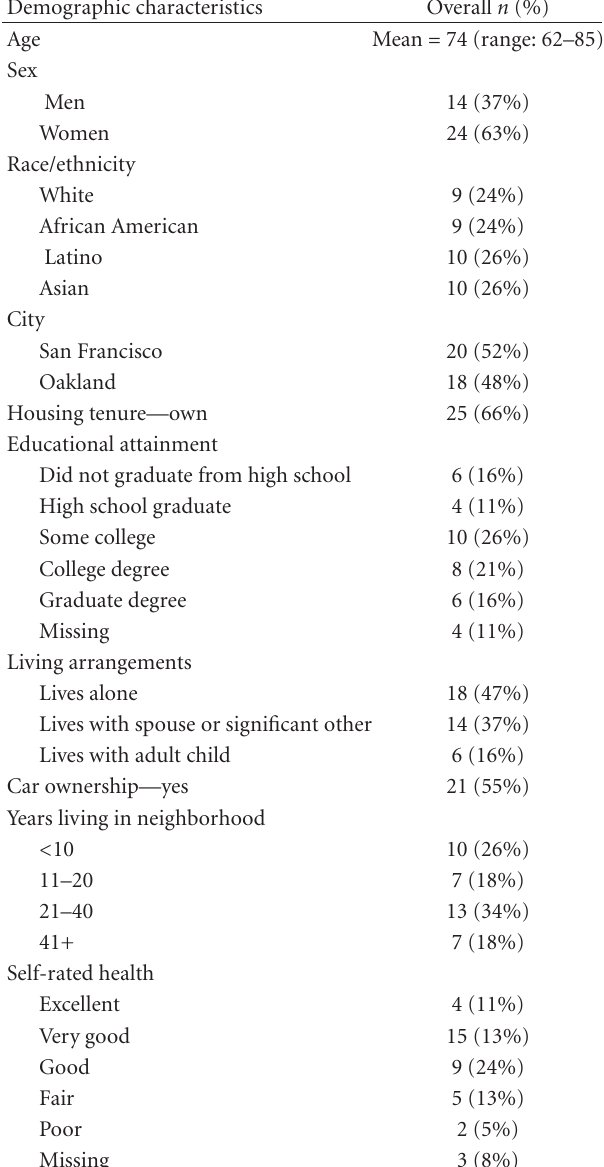
Table 1: Descriptive information of respondents ( n = 38). Demographic